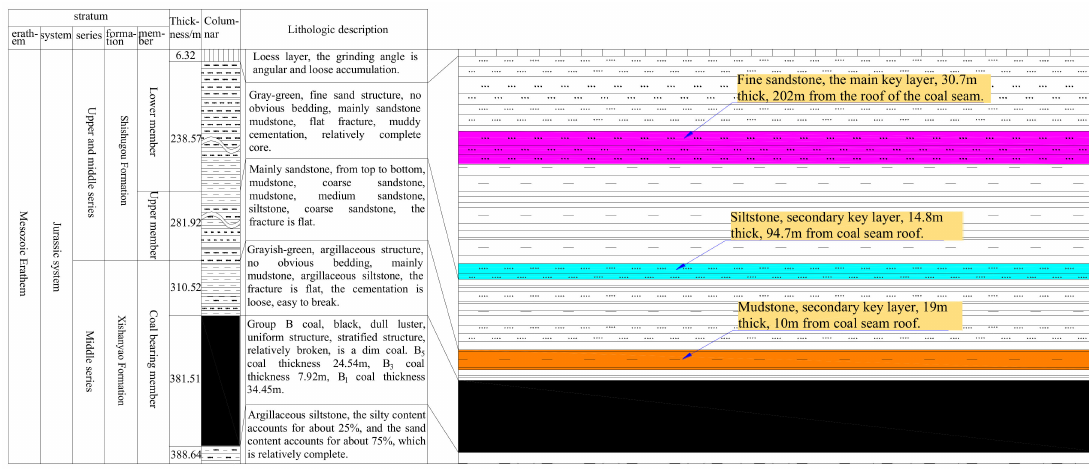
Figure 2. Stratigraphy and lithologies in the studied area.